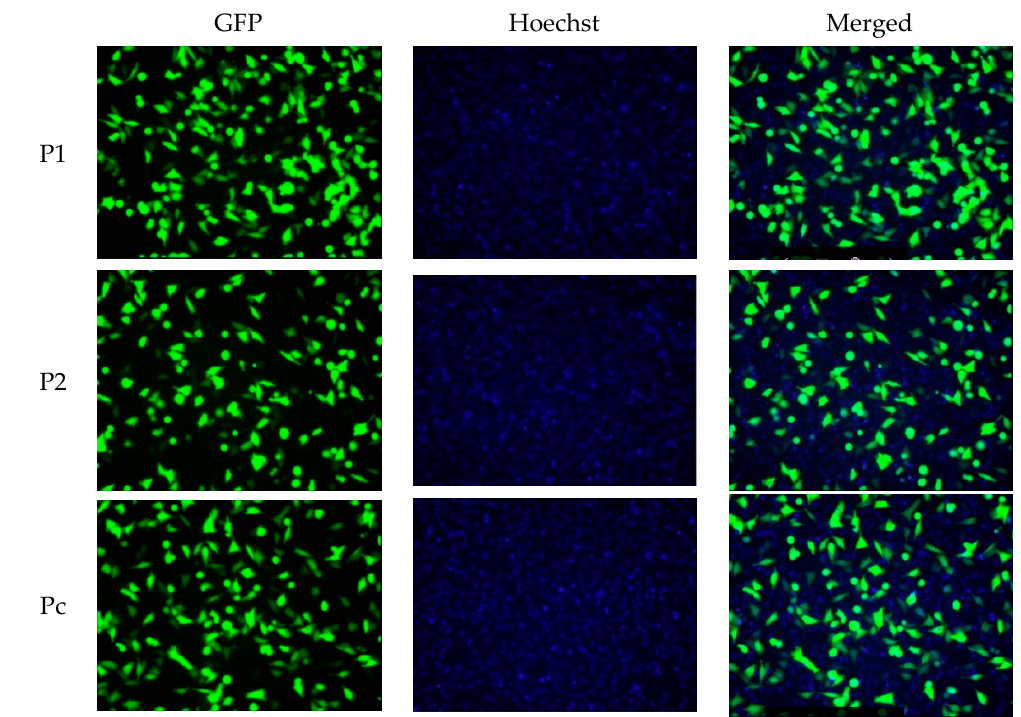
Figure 1. Transfection of A375 cells. A375 cells were transfected with two YB-1 silencing shRNA plasmids (P1 and P2) with one nontargeting shRNA plasmid (Pc) as a negative control. All plasmids were containing a pGFP-V-RS vector that emits GFP fluorescent light upon successful expression of each plasmid. Images were captured Cytell™ Cell Imaging System.